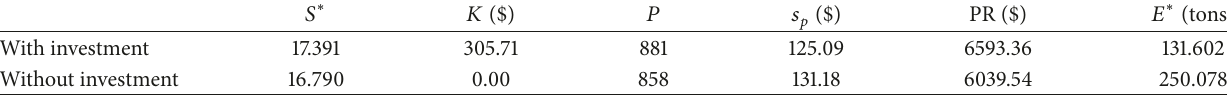
Table 4: Optimum results of emission minimization policy.